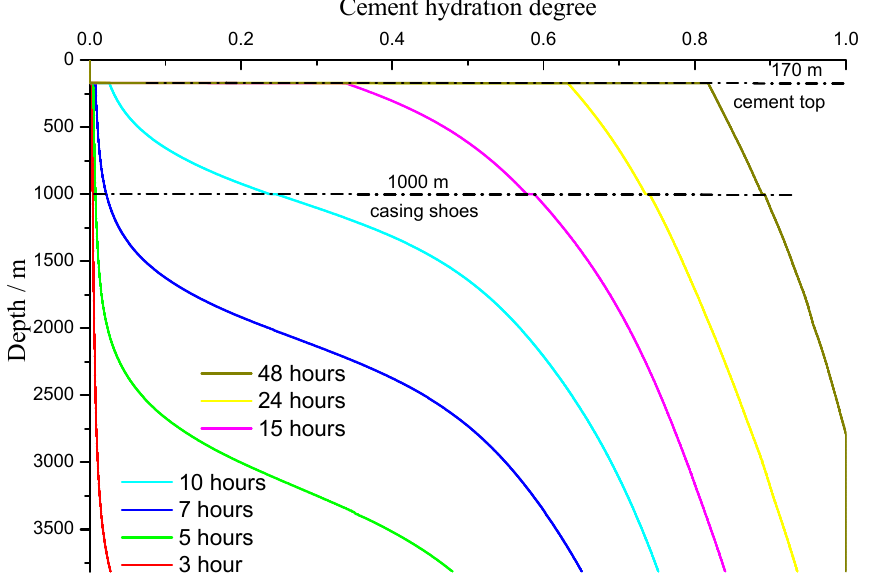
Figure 7. Transient distribution of cement hydration in the wellbore.